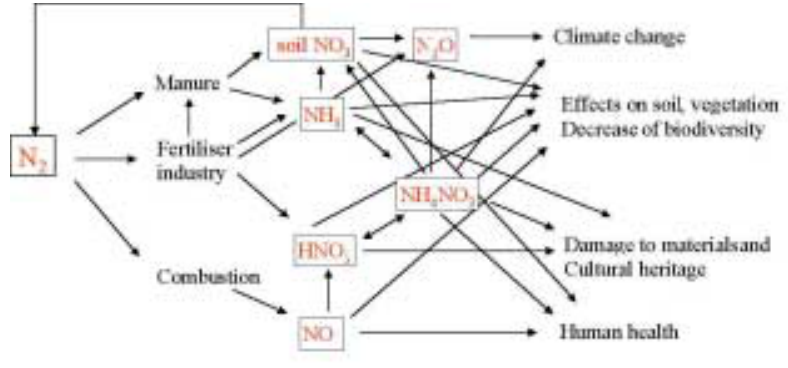
FIGURE 7. Different sources and effects of nitrogen in the environment and their